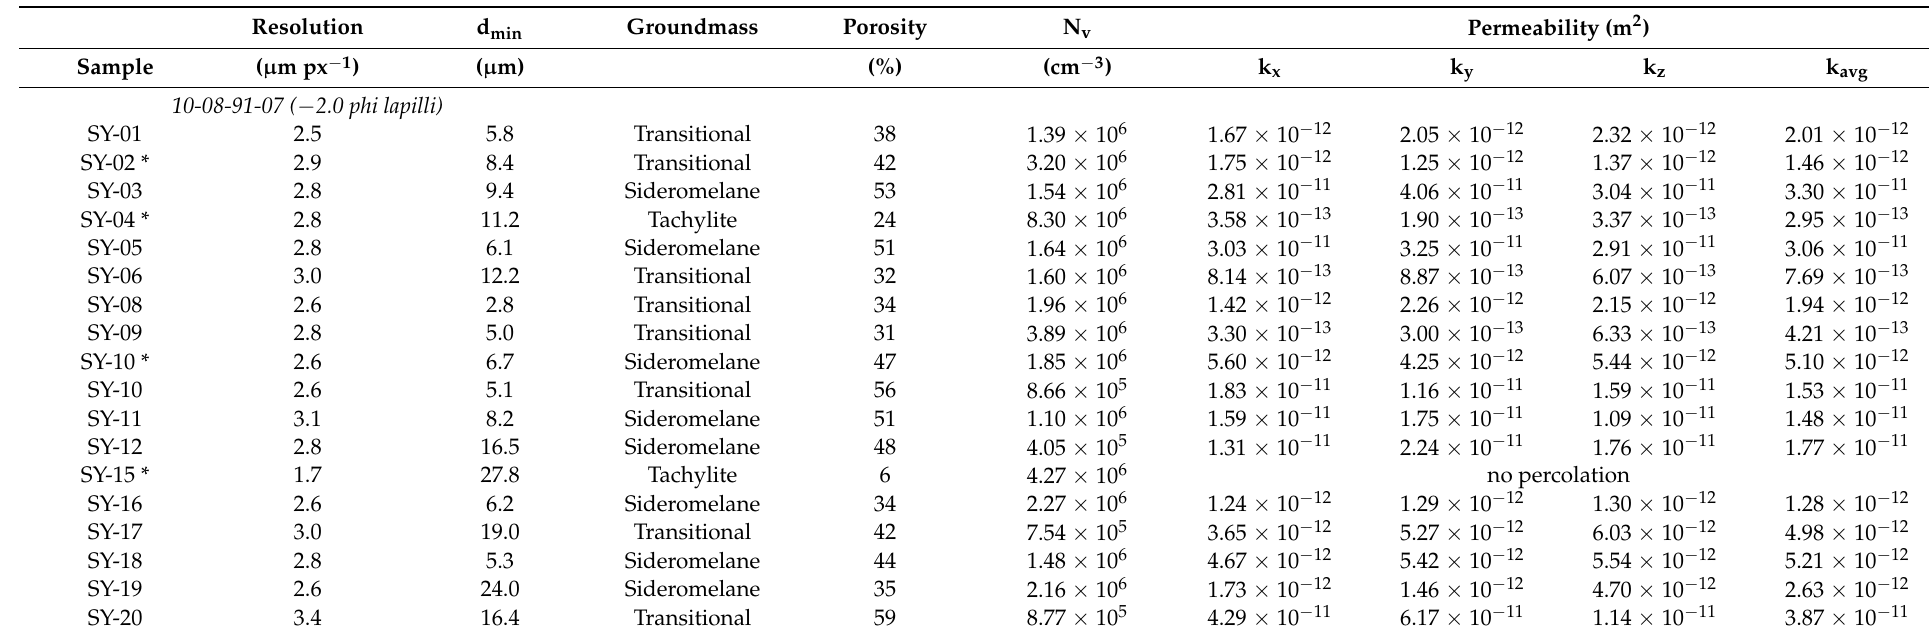
Table 2. Textural parameters of lapilli from 3D